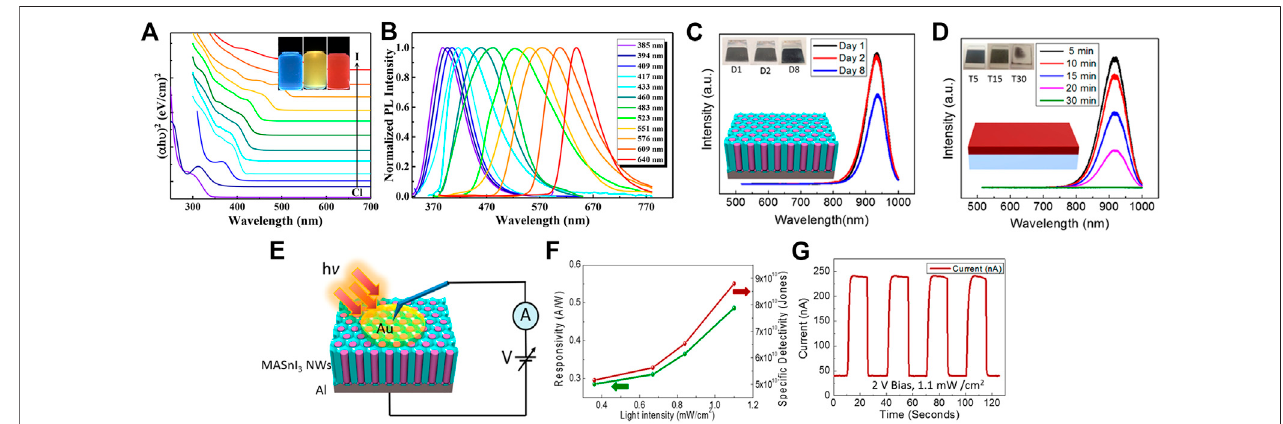
FIGURE 7 | (A) PL and (B) absorption characteristics of Cs 3 Sb 2 X 9 QDs where the inset shows PQDs under UV light excitation. Photographs of as-obtained colloidal Cs 3 Bi 2 X 9 (X (cid:2) Cl, Cl 0.5 Br 0.5 , Br, Br 0.5 I 0.5 ,I). (C) PL characteristics ofSn perovskite NWs where insetshows the Sn perovskite NWs after 1, 2, and 8 days. (D) PL characteristics of Sn perovskite thin fi lms where inset shows Sn perovskite thin fi lm sample after 5, 15, and 30 min. (E) Schematics of the Sn-based perovskite NW